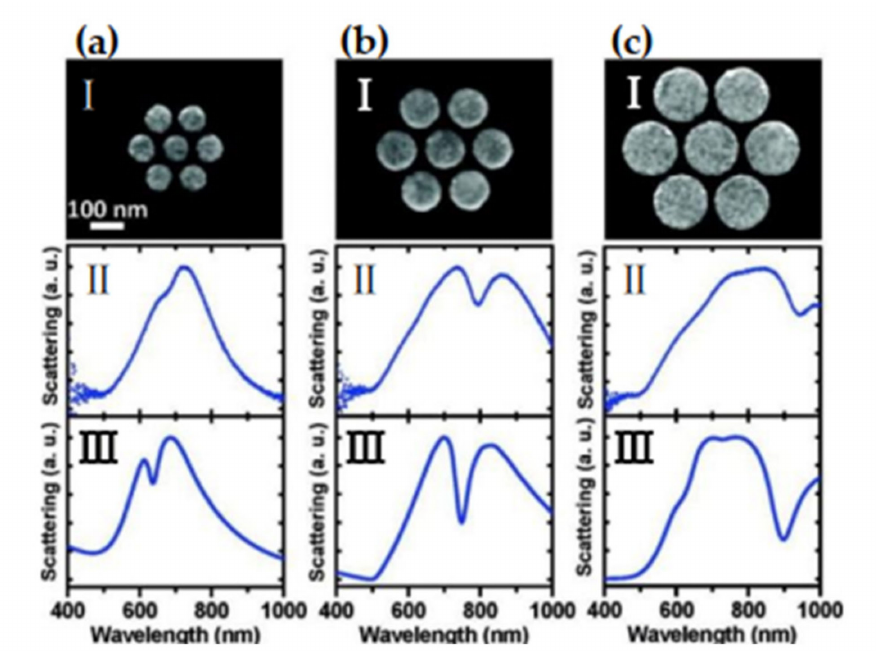
Figure 22. Size dependence of the scattering spectrum of a heptamer: ( a ) 85-nm diameter constituent particles; ( b ) 128-nm diameter particles; and ( c ) 170-nm diameter particles. In all cases, the gap sizes between the particles in the heptamers were nominally ∼ 15 nm. ( I ) SEM images obtained using an FEI Quanta 400 SEM; ( II ) experimentally obtained dark-field scattering spectra, obtained with unpolarized light, of each individual cluster shown in ( I ); and ( III ) FDTD calculations of the dark- field spectral response of the same structure. Reprinted with permission from Ref. [203]. Copyright 2010 American Chemical